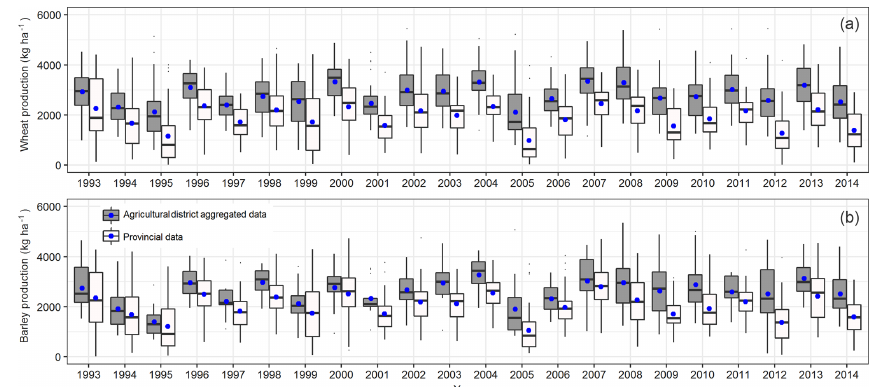
Figure 2. Temporal series of wheat (a) and barley (b) yields for the provincial data and the aggregated agricultural district data at the province scale for the common period 1993–2014. The solid black line shows the median, and the blue dot shows the